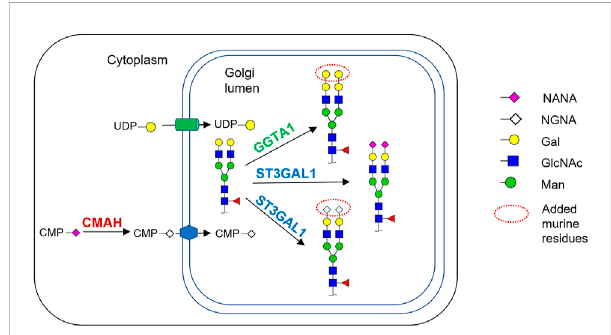
FIGURE 1 SchematicoftherelevantpartsoftheN-glycosylationpathwayin murine myeloma cell lines and the CHO cells engineered in this work. Cytidine-5 ′ -monophospho-N-Glycolylneuraminic acid (CMP-NGNA) is synthesized in the cytosol by the CMP-Neu5Ac hydroxylase (CMAH) hydroxylation of the N-acetyl group of Cytidine-5 ′ - monophospho-N-acetylneuraminic acid (CMP-NANA). In the Golgi, CMP-NGNA is transferred to galactose-containing glycan substrates by sialyltransferases denoted by ST. The Golgi glycosylation enzyme GGTA1 transfers galactose from UDP-gal to the terminal galactose residue, producing the α -Gal glycan. In this work, the CHO cells were genetically engineered to express CMAH and